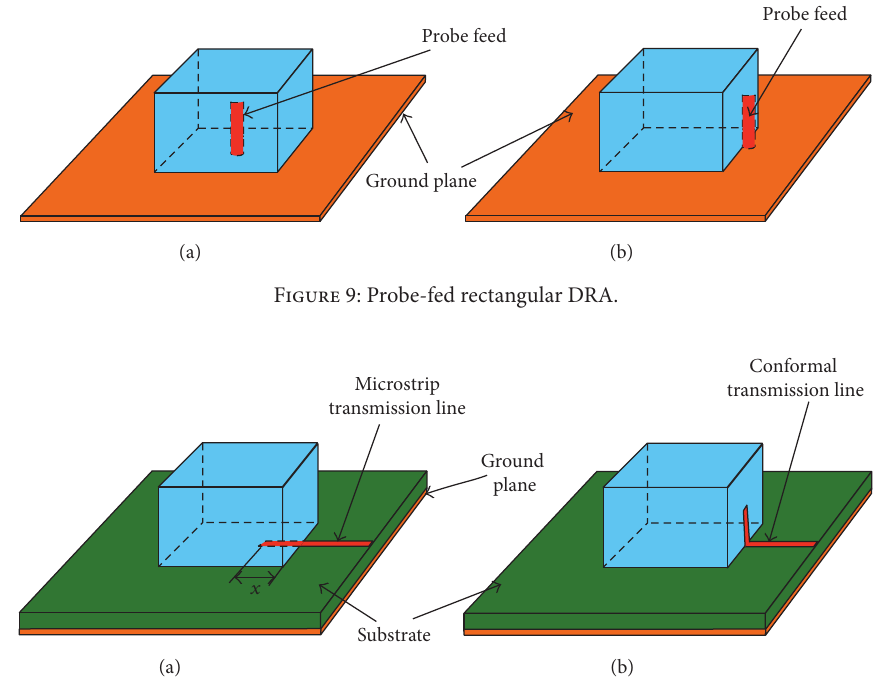
Figure 10: Three-dimensional view of conventional (a) and conformal (b) microstrip transmission line feeding